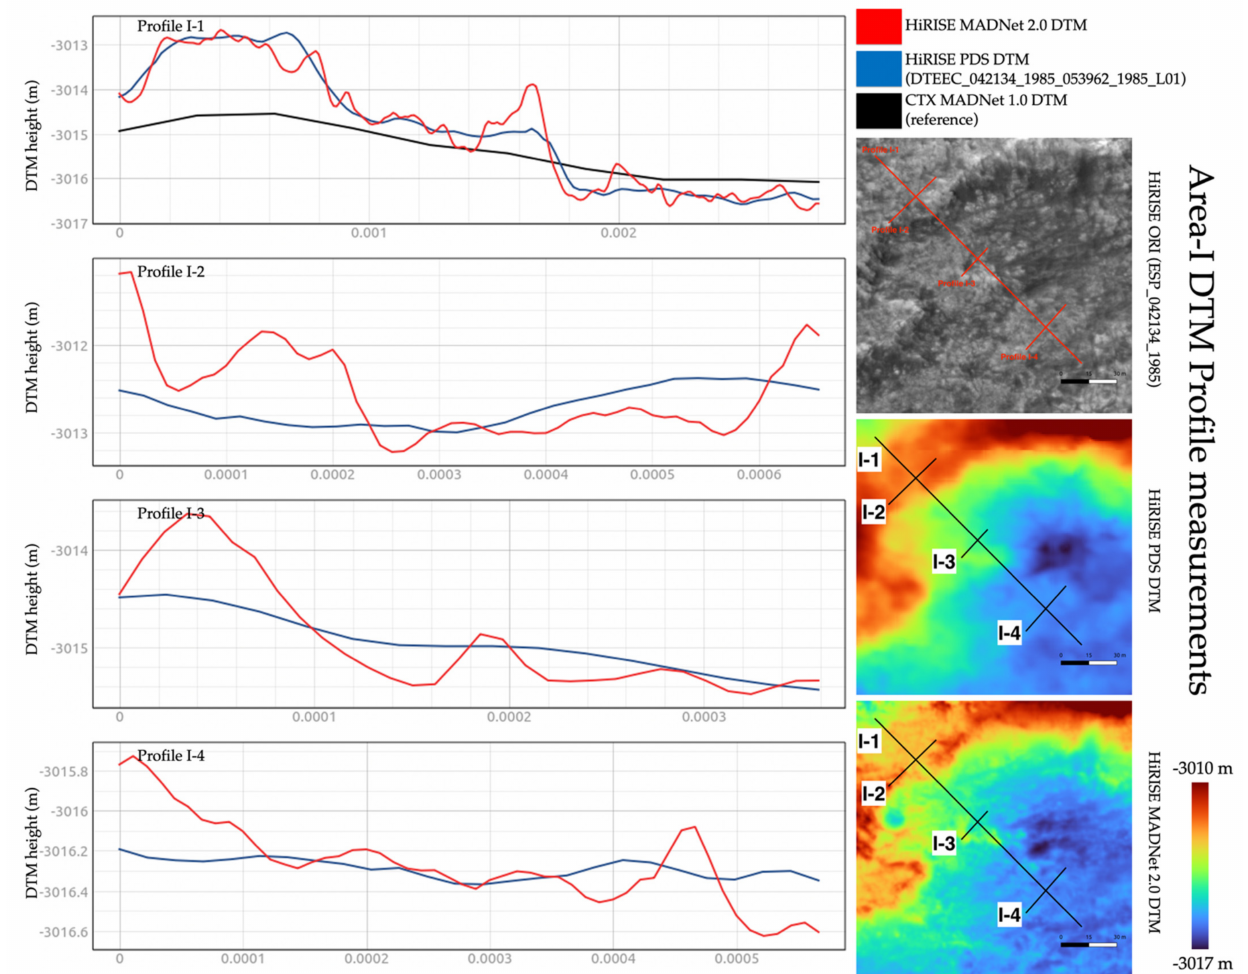
Figure 24. DTM profile measurements of the 1 m/pixel PDS HiRISE DTM, the 25 cm/pixel MADNet 2.0 DTM, and the 12 m/pixel MADNet 1.0 CTX DTMs (the reference DTM) for area-I (location is shown in Figure 10). N.B. all profile measurements begin from the labelled side of the profiles lines that are shown on the image and DTMs to the other end of the